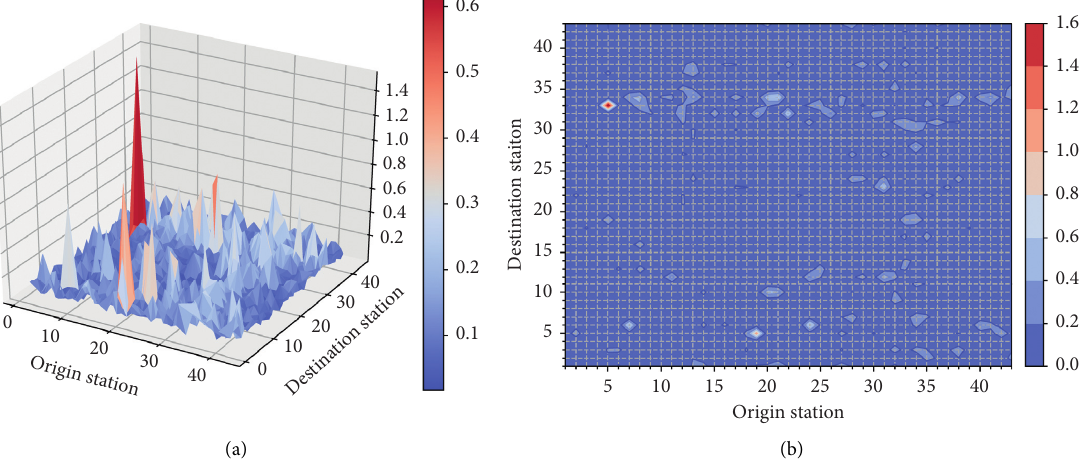
Figure 8: RMSN for the origin-destination matrix. (a) Three-dimensional surface graph of RMSN. (b) Contour graph of